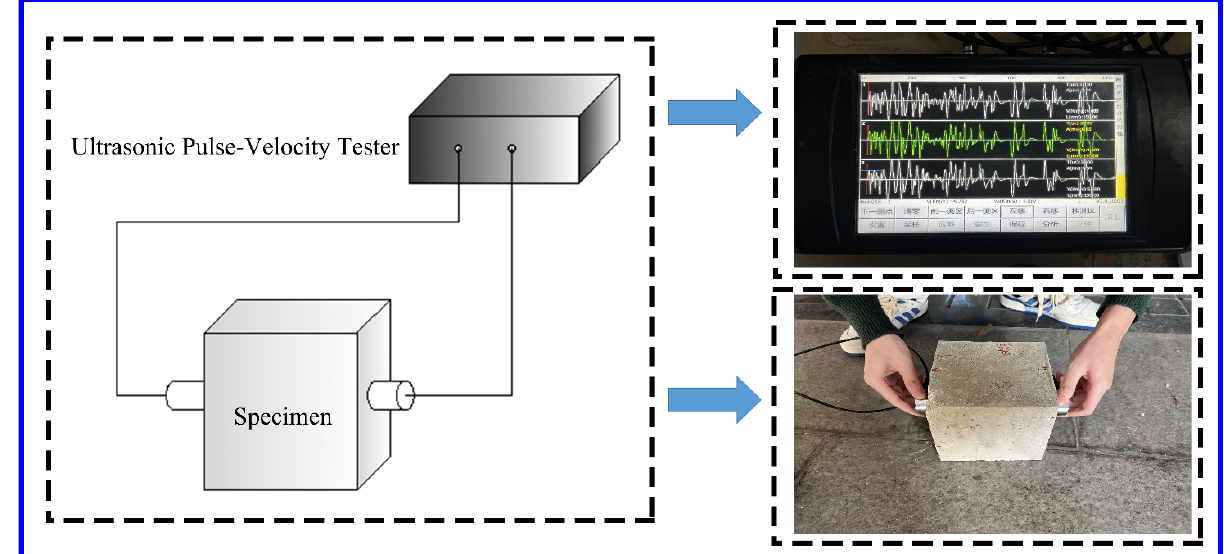
Figure 3. Ultrasonic pulse velocity measurement.